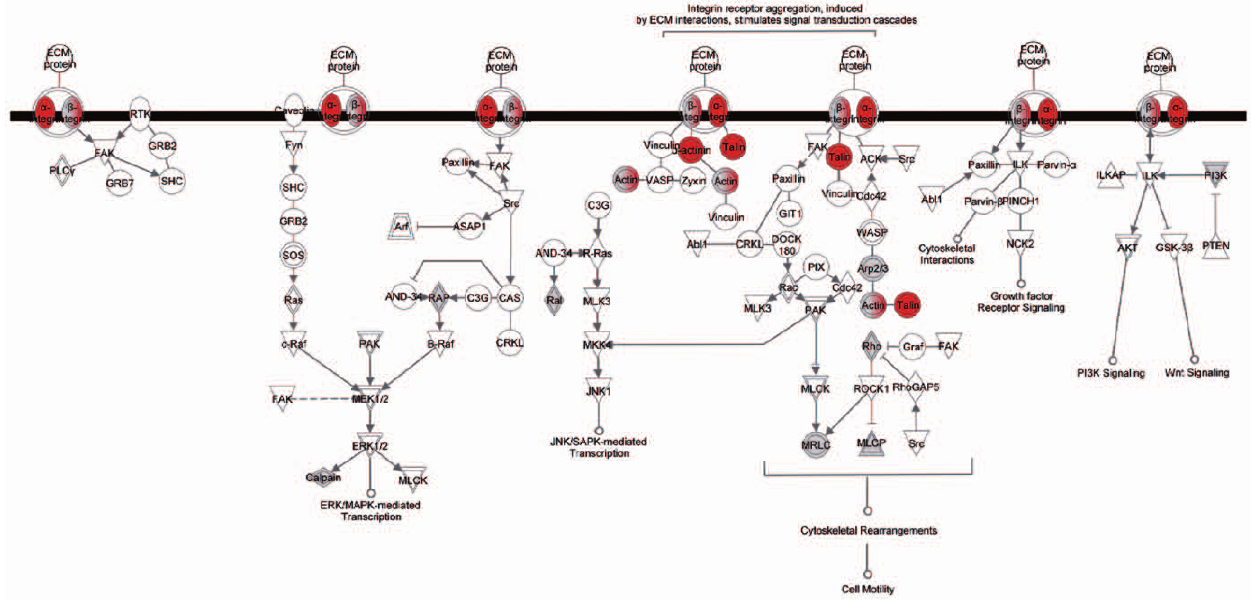
Figure 7. Integrin signaling pathway Integrin signaling pathway generated by the Ingenuity Pathway Analysis (IPA) software. Integrin and actin cytoskeleton signaling pathways were the top two pathways associated with cell-to-cell signaling. Each node represents a protein; the proteins in shaded nodes in the pathway are identified/relate to an identified protein in the proteomic analysis. While proteins in clear nodes are part of the pathway but have not been identified in the GV oocyte or cumulus datasets. Proteins in red nodes were shown higher expression in cumulus cells compared to GV oocyte.